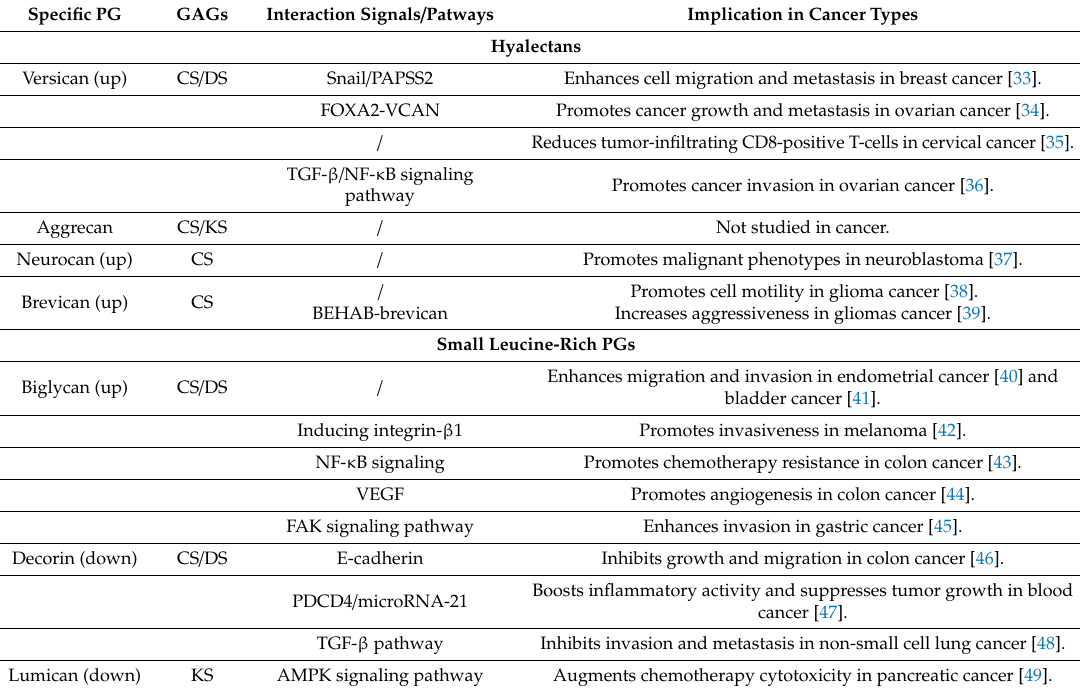
Table 1. Major PGs grouped according to their location, interaction signals, and their predominant GAGs during